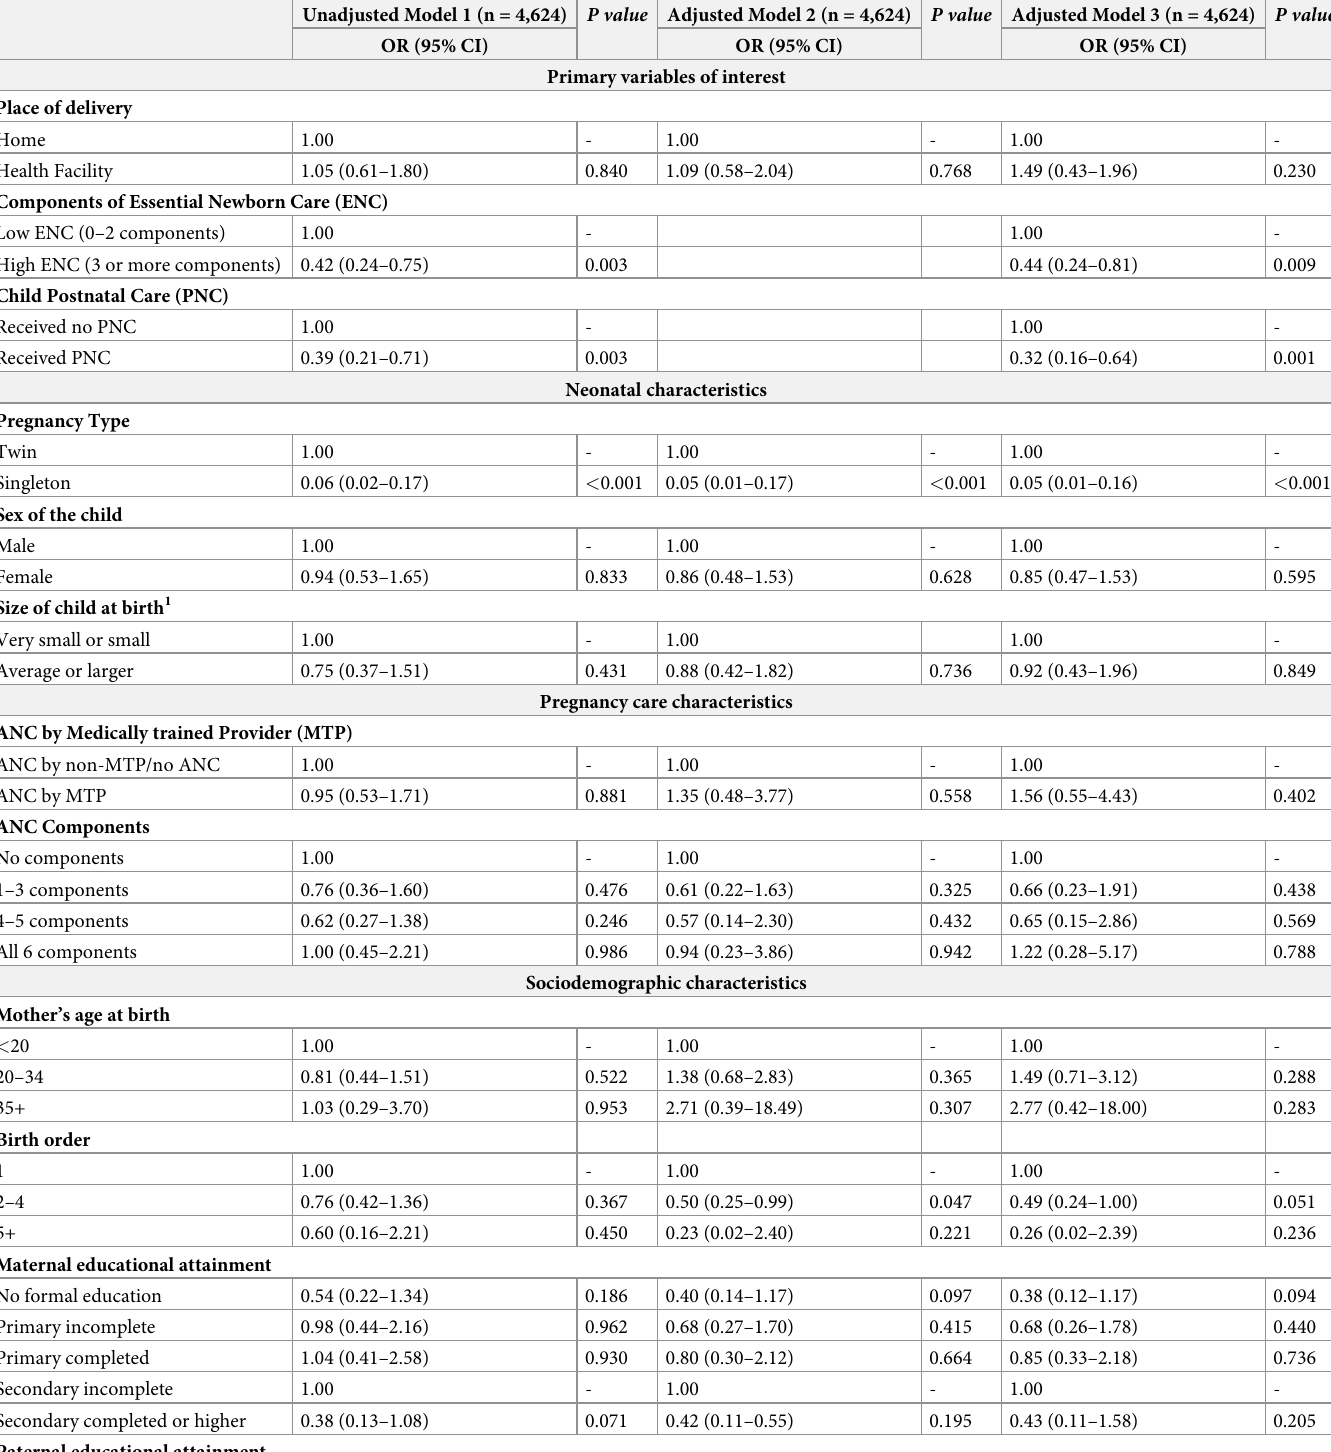
Table 5. Logistic regression estimates of the association of early neonatal mortality with delivery care, essential newborn care, and child postnatal care controlling for neonatal, pregnancy care, sociodemographic and community characteristics, Bangladesh DHS